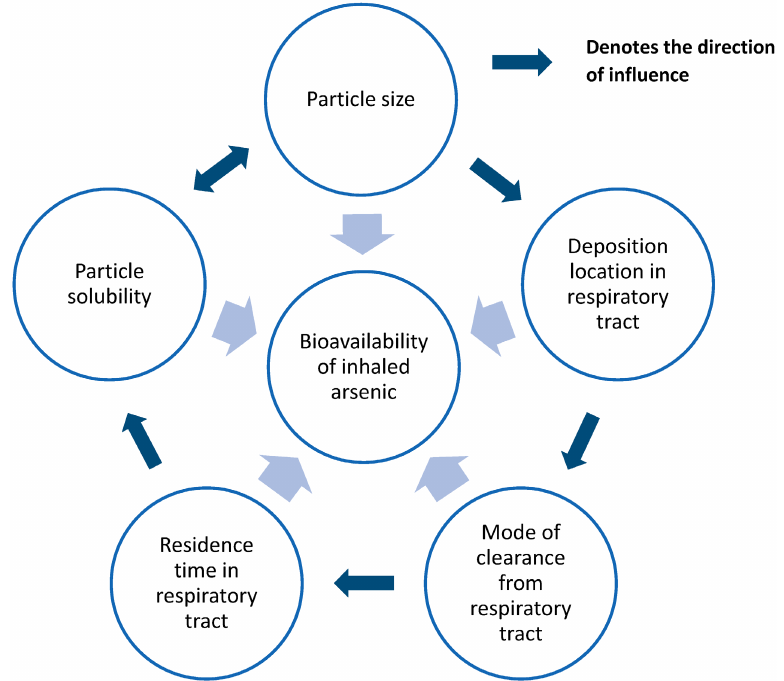
Figure 4. Diagrammatic representation of the interactions between key factors governing the pulmonary bioavailability of